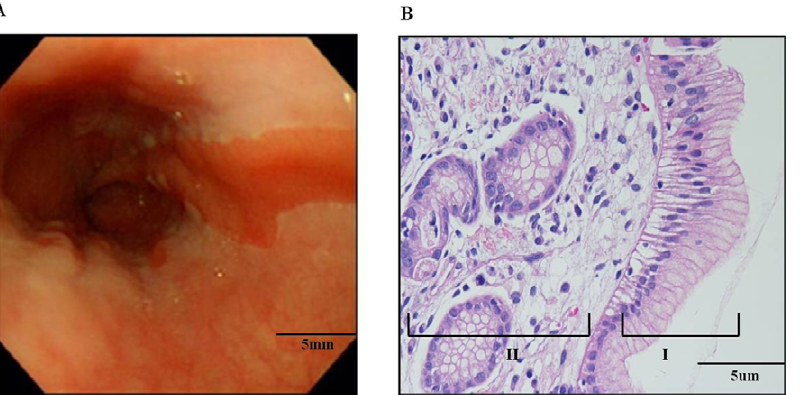
Figure 6. Endoscopic finding and histological examination of Barrett’s metaplasia. Endoscopic finding of esophagus shows irregular Z- line, elongated salmon patched tongue like projection of distal columnar epithelium (A). Histological examination (x200) of esophageal lesion reveals surface glandular epithelium with tall columnar cells punctuated by round to oval goblet cells (I). The columnar epithelium resembles intestinal epithelium but is not identical in nature. Barrett’s metaplasia is also characterized by universal presence of chronic inflammation (II) (B).